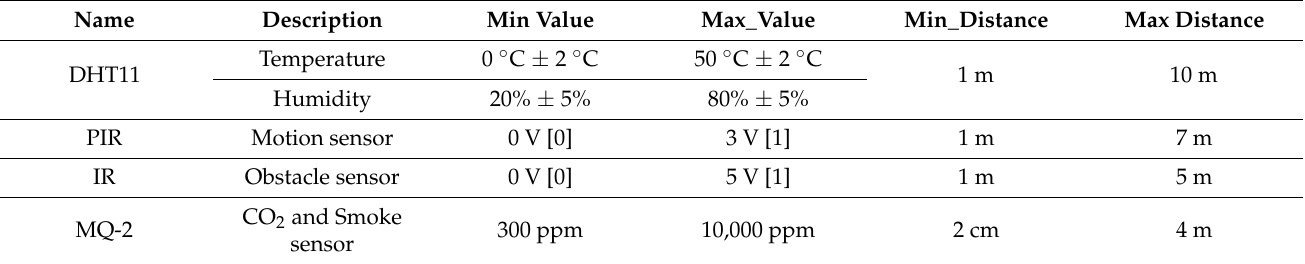
Table 2. Sensor’s operation